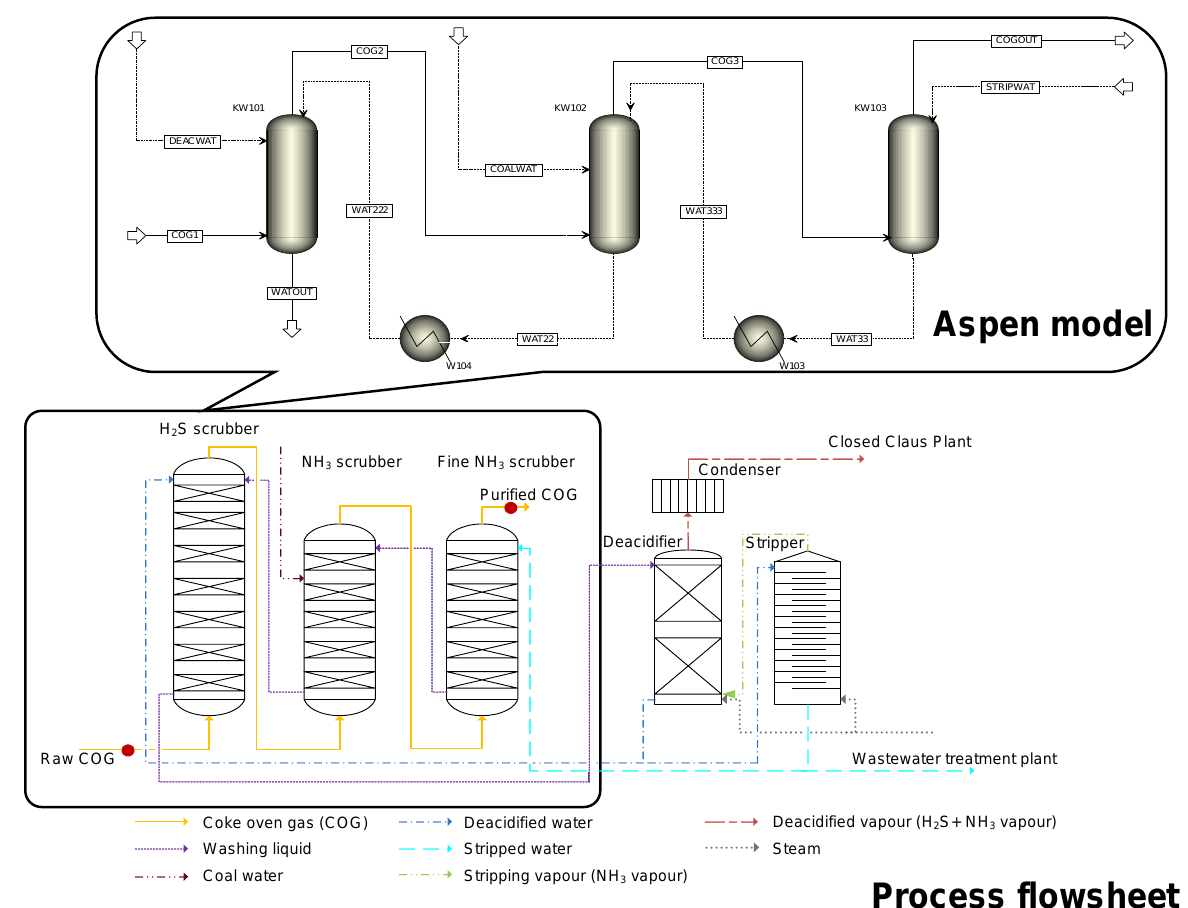
Figure 2. Coke oven gas purification process flowsheet.